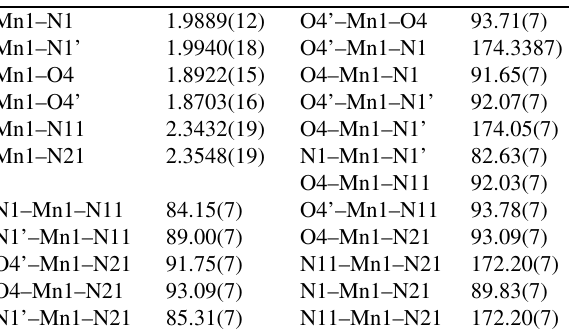
Table 3. Selected geometric parameters for compound 2